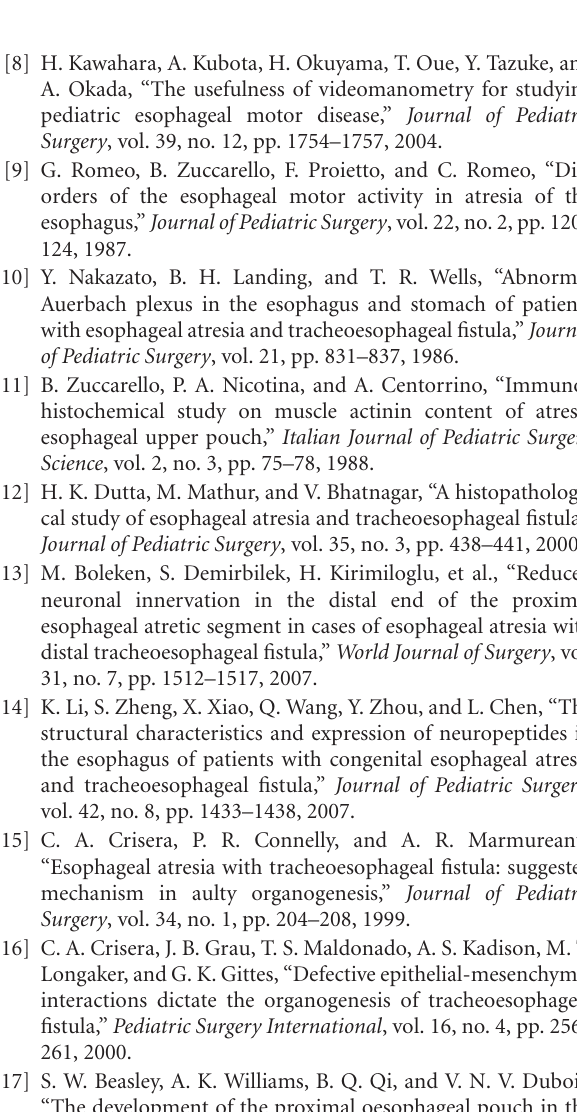
Figure 6: Chromogranin A(CgA). Positive immunoreactivity is more marked in (a) the UEP than in (b) the